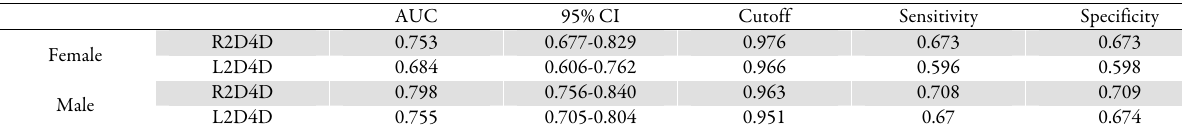
Table 5. ROC analysis for optimal cutoff point of digit ratio for obesity as measured by BMI*